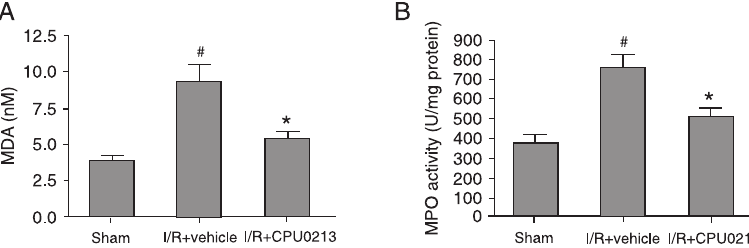
Figure 5. Malondialdehyde (MDA) levels in serum and myeloperoxidase (MPO) activ- ity in myocardial tissues after ischemia-reperfusion. A , MDA levels in serum. B , MPO activity in myocardial tissues. Data are reported as means ± SEM for 6 rats/group. # P < 0.01 vs Sham, *P < 0.05 vs I/R + vehicle (one-way ANOVA followed by the Bonferroni post hoc test).